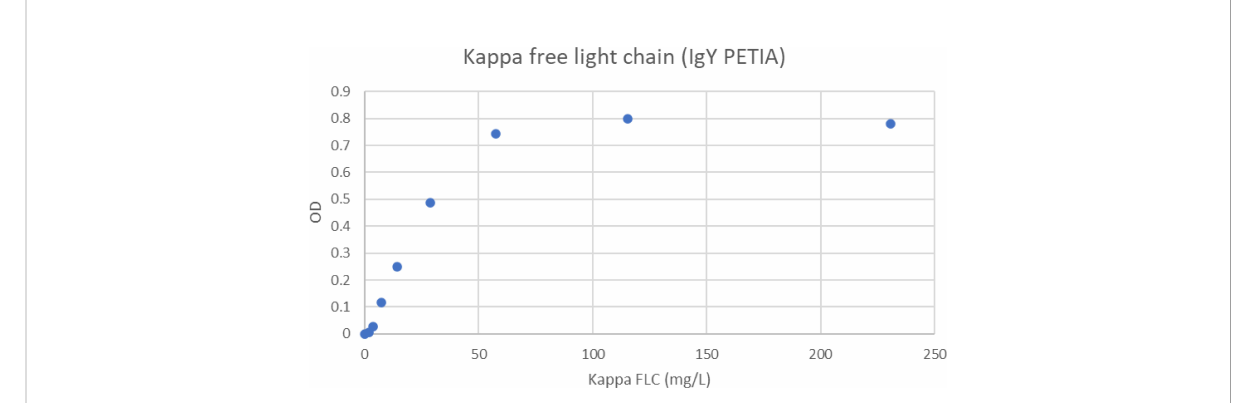
FIGURE 2 Antigen excess curve for kappa FLC PETIA. The fi gure shows the free kappa chain concentration in the samples versus the absorbance readings. The samples were analyzed as singletons. The plot shows that antigen excess is not present below 230 mg/L free kappa